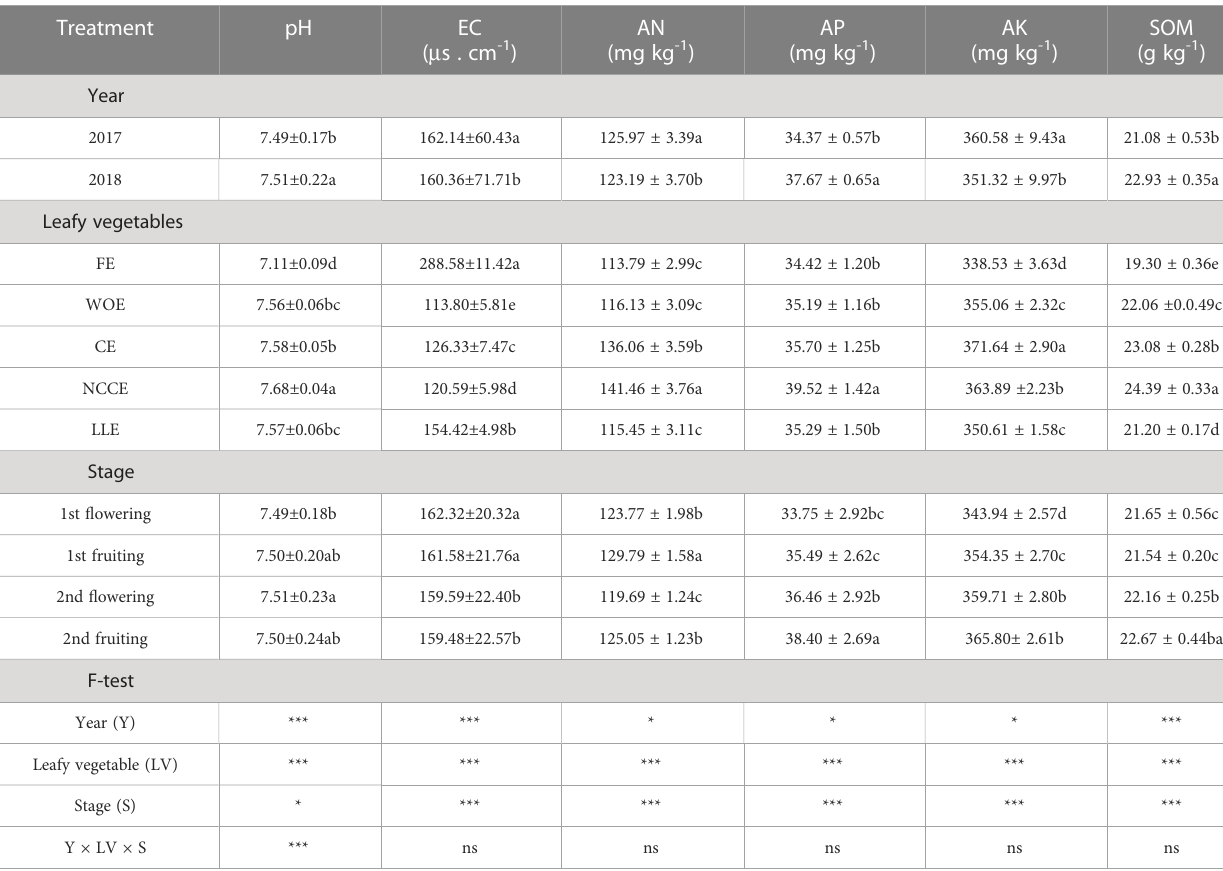
TABLE 6 Effect of different leafy vegetable rotation systems on soil chemical properties of eggplant at different growth stages during the year 2017 and 2018. Treatment